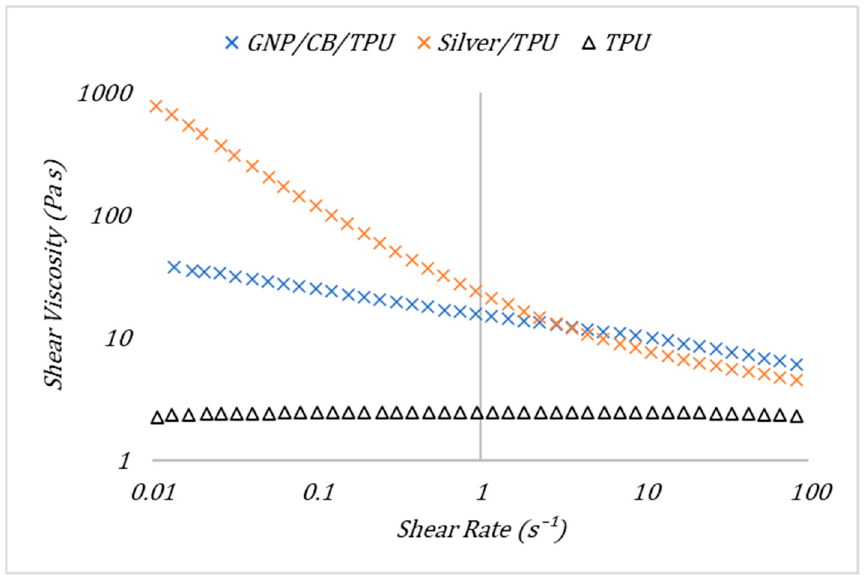
Figure 3. The effect of shear rate on the shear viscosity of the GNP/CB/TPU ink, the Silver/TPU ink and the unfilled TPU resin system from a downwards shear ramp.